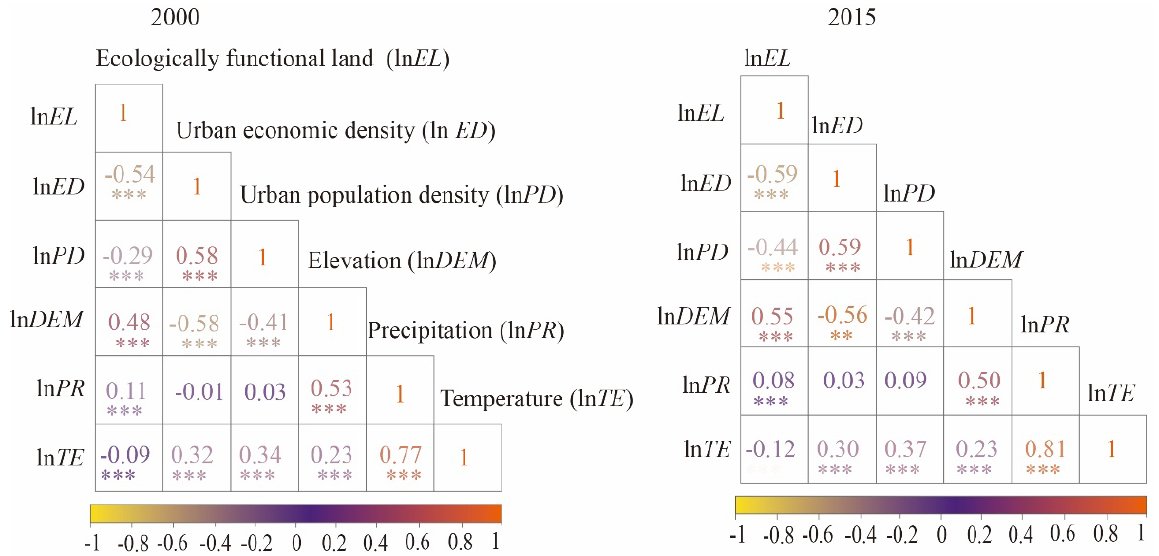
Figure 2. Correlations among ecologically functional land (ln EL ), urban economic density (ln ED ), and control variables. ** and *** denote significance at the 5% and 1% levels, respectively. Table 2. Results of the variance inflation factor (VIF).